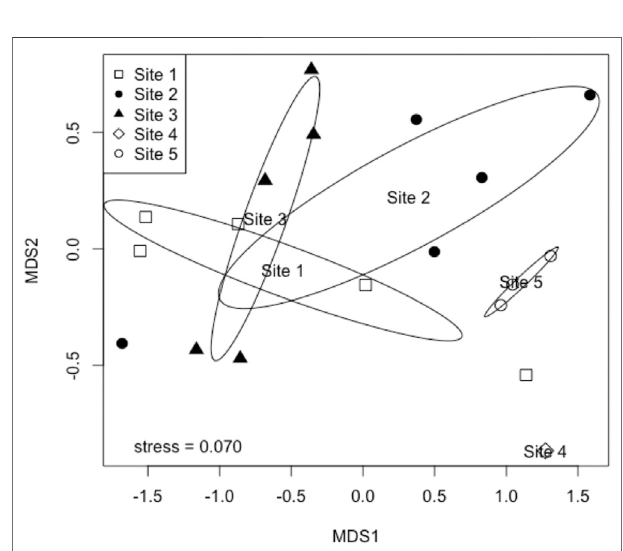
FIGURE 4 | An nMDS plot created using data collected regarding all debris items across all locations within each of the fi ve sites using the Bray- Curtis dissimilarity metric and plotted in two dimensions. Data was not transformed. Each point on the fi gure represents a transect, and the different shapes represent each of the fi ve